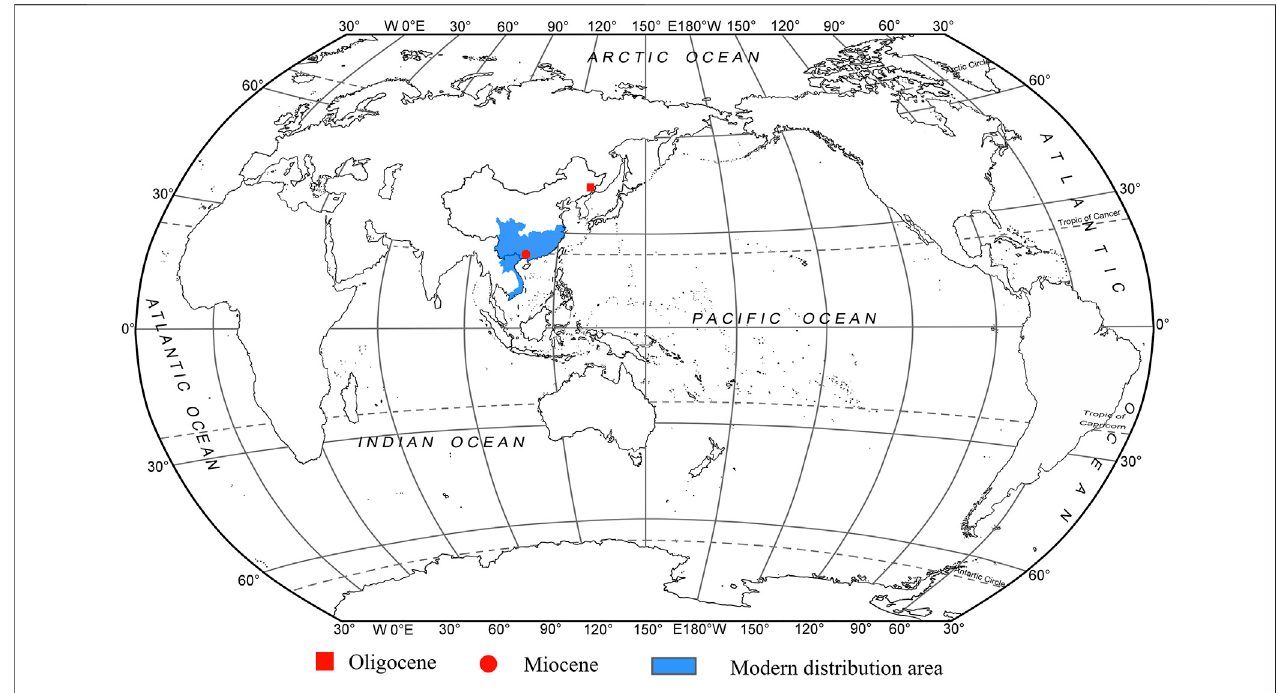
FIGURE 1 | Modern distribution and fossil records of Fokienia